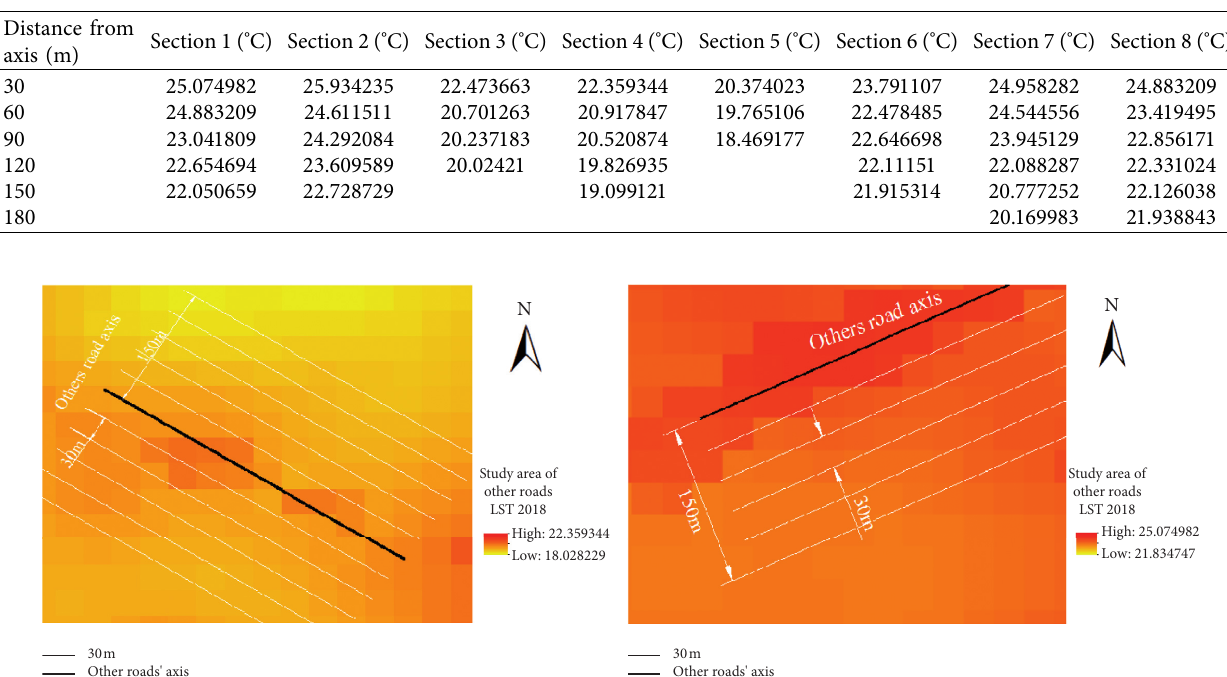
Figure 8: LST radiation in a typical area of highway. Table 5: Other grades of road LST propagation data.